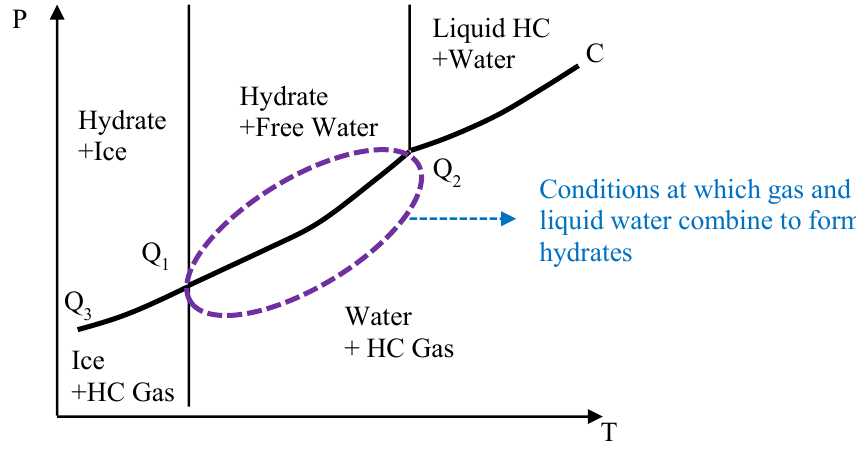
Figure 5—Phase diagram for water/hydrocarbon mix (PSU 2017).